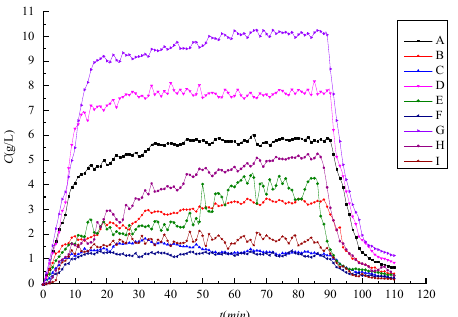
Figure 9. Diagram showing changes over time without a control system.